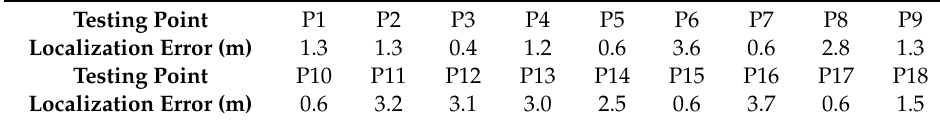
Table 2. The errors between 18 planned test points and their corresponding estimated